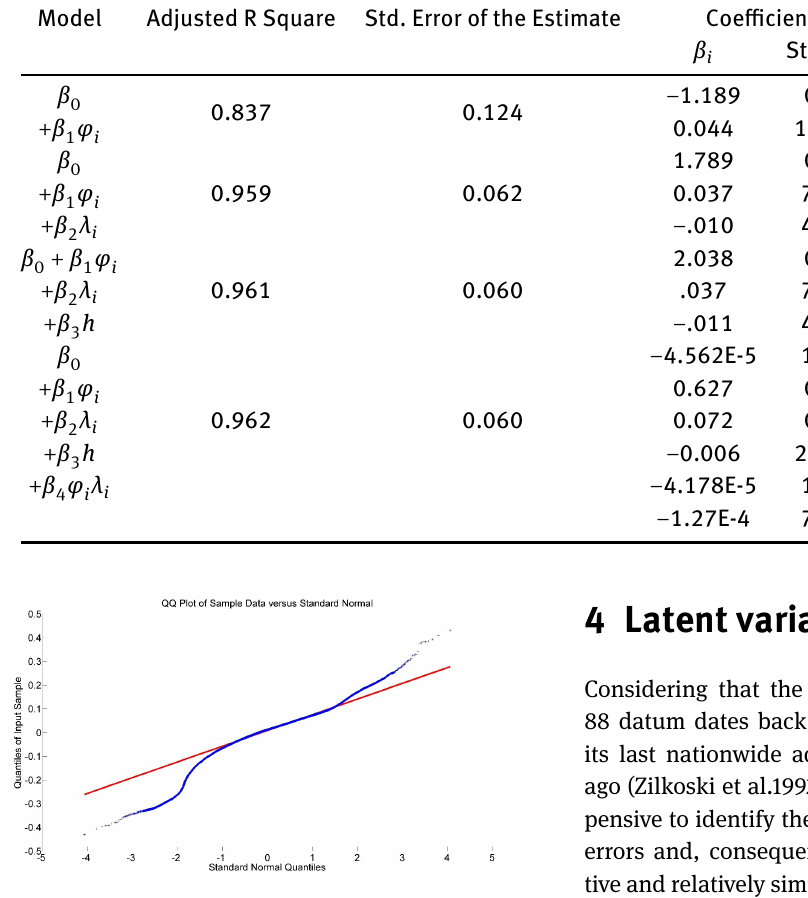
Figure 3: The Q-Q plot of the model residuals as exemplified by the blue symbols (the quantiles of the residuals versus the theoretical quantiles from a normal distribution. A straight line, as indicated by the red line, is expected if the residuals are